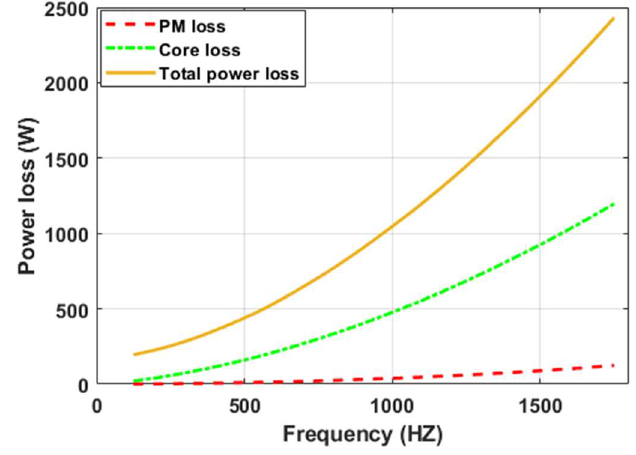
Figure 6. PMs, core, and total losses versus frequency at ambient temperature (20 °C).